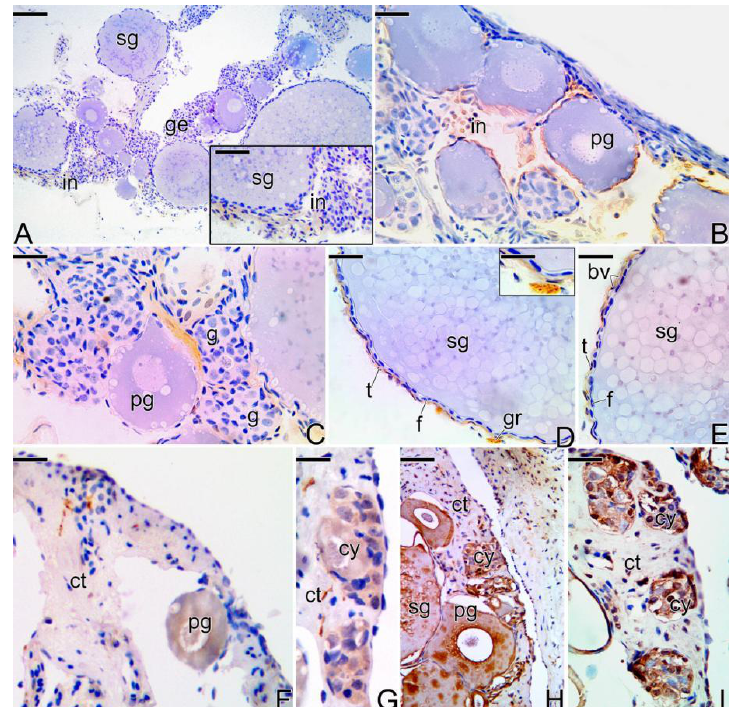
Figure 10. ( A – I ) Immunohistochemistry for detection of MMP-2 ( A ), MMP-9 ( B – D ), and MMP-14 ( E ) metalloproteinases in the intermediate transitional ovary of S. marmoratus . ( F – I ) Immunohistochemistry for detection of MMP-14 ( F – G ), MMP-9 ( H ), and MMP-2 ( I ) metalloproteinases in final transitional gonad (intersex) of S. marmoratus . Secondary growth oocyte (sg), interstitium (in), germinal epithelium (ge), primary growth oocyte (pg), gonia (g), granulocyte (gr), theca cell (t), follicle cells (f), germline cyst (cy), connective tissue (ct). Counterstaining: Harrys Hematoxylin ( A – I ). Bar: 100µm ( A ), 40µm ( A -inset), 20µm ( B – I ), 15µm ( G ), 25µm ( H ), 5µm ( D -inset). At the end of the sex reversal process, the gonad of the secondary male shows a weak reaction